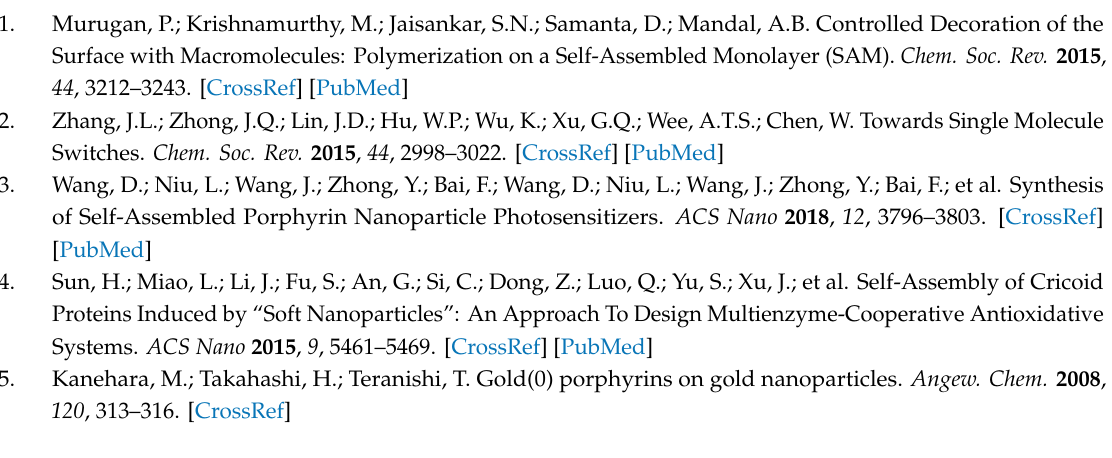
Figure S1: 1 H NMR spectrum of the 5,15,-Di(phenyl) 10, 20-Di-benzamide, N -ethyl, N -1,3,5 Tri-aminotriazine, 21H,23H-porphine recorded in methanol; Figure S2: 1 H NMR spectrum of the Di-Triazine-Porphyrin, recorded in DMSO- d 6 ; Figure S3: Selected region of the 1 H NMR spectrum of the Di-Triazine-Porphyrin after the addition of 10 µ L of D 2 O; Figure S4: gCOSY spectrum of the Di-Triazine-Porphyrin recorded in DMSO- d 6 ; Figure S5: ESI-MS spectrum of Di-Triazine-Porphyrin; Figure S6: EDX spectrum of the Au NPs conjugated with the Di-Triazine-Porphyrin; Figure S7: UV–vis absorbance spectrum of the as synthesized aqueous Au NPs 1.97 × 10 − 7 M solution; Figure S8: UV–vis absorbance spectra of the porphyrin CH 3 OH solution at di ff erent concentrations; Figure S9: Trend of the luminescence spectra of the porphyrin CH 3 OH solution at di ff erent concentrations; Figure S10: comparison between the PL intensities of the porphyrin CH 3 OH solutions and those obtained during the Au NPs titration at di ff erent concentrations; Figure S11: DLS measurements for the 6.57 × 10 − 9 M Au NPs (black line) and 6.22 × 10 − 6 M Au NPs–porphyrin nanostructure methanol solutions (red line). List of the atomic coordinates of the optimized structures of the CL and BL